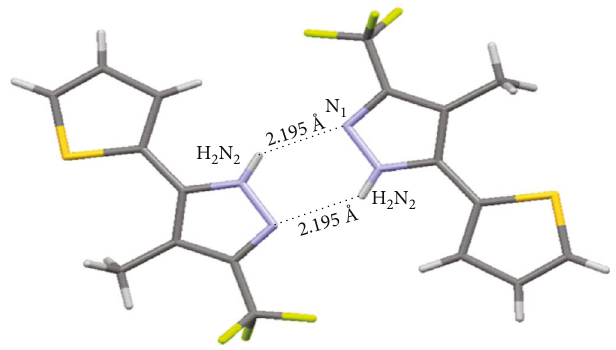
Figure 6: A packing diagram of 5(3)-tri fl uoromethyl-4-methyl- 3(5)-thien-2-yl-1 H -pyrazole (5) showing the molecules linked by hydrogen bonds. Hydrogen bonds are shown as dashed